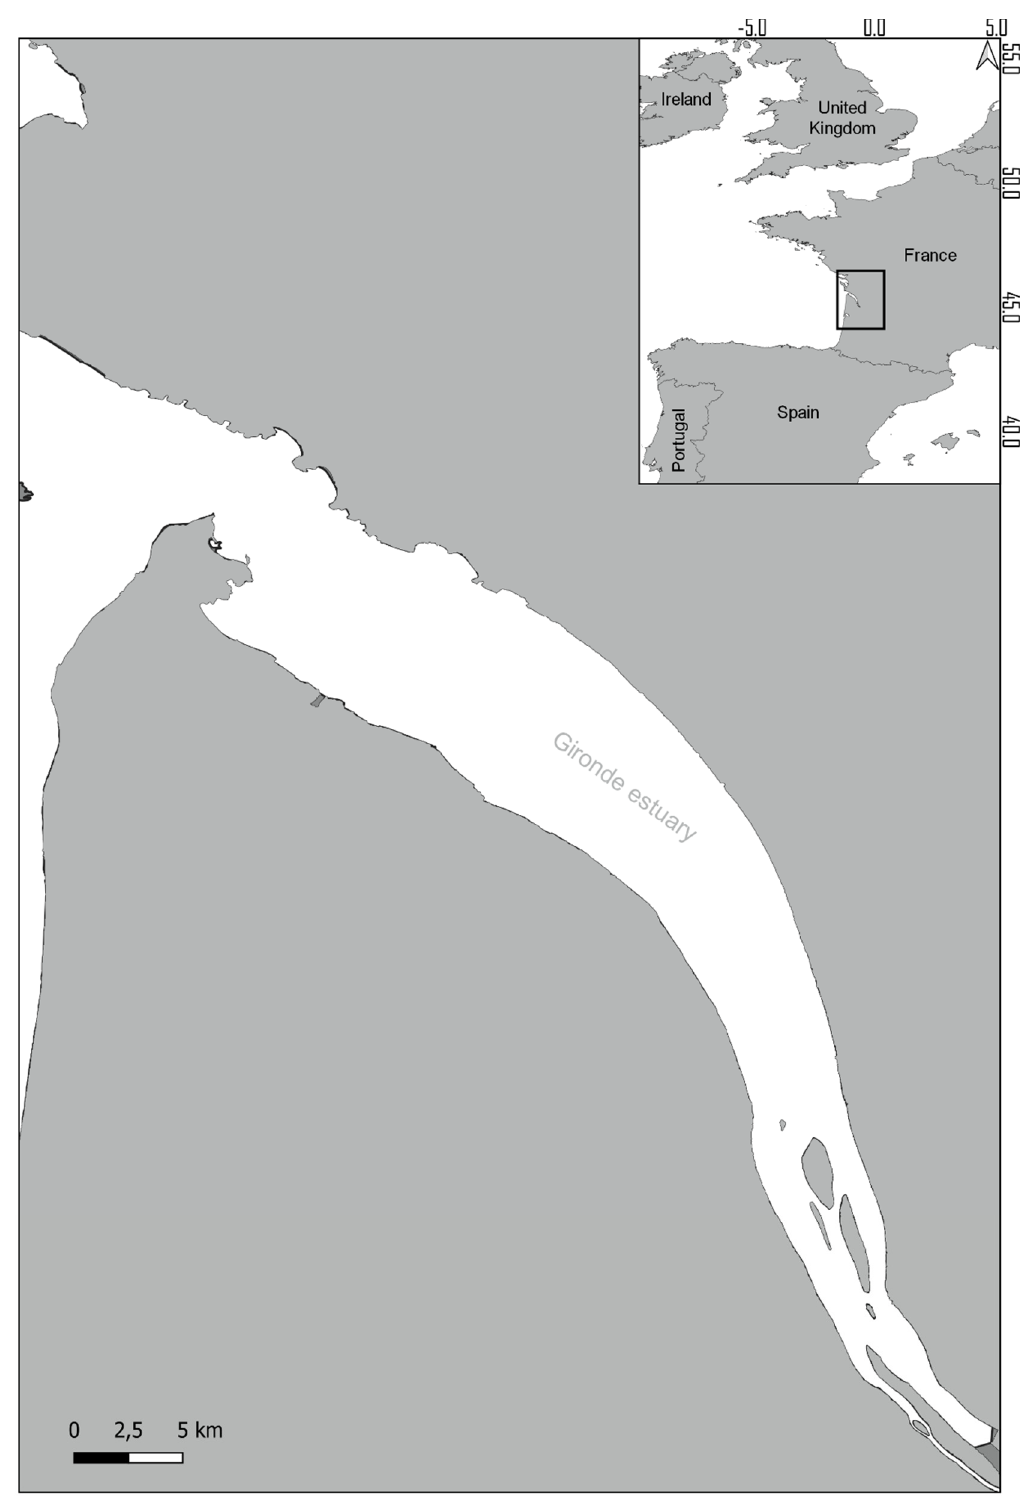
Figure 1. Map of the Gironde Estuary .